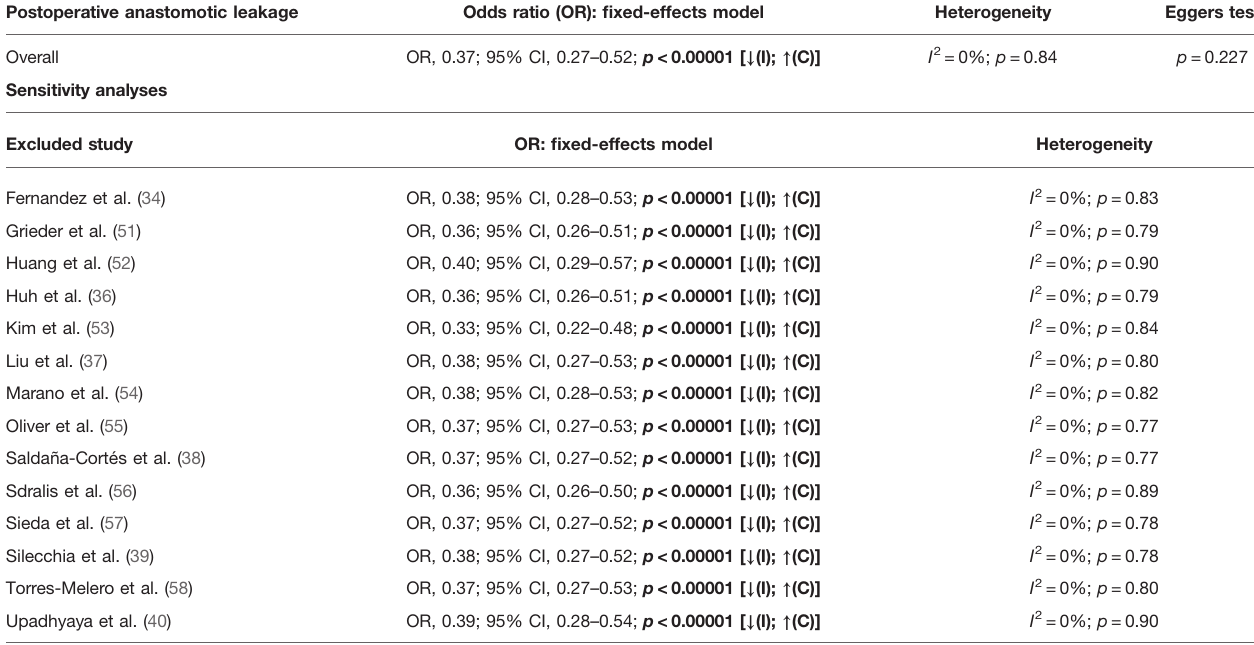
TABLE 4 | Fixed-effects meta-analysis for postoperative anastomotic leakage in the intervention and control